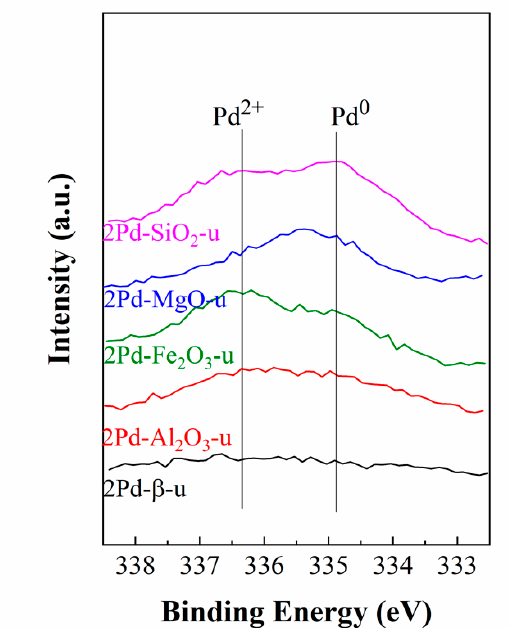
Figure 13. Pd 3d core level spectra for Pd-based catalysts, after FUR oxidative condensation reaction. Experimental conditions: temperature: 170 °C, time: 3 h, catalyst loading: 0.05 g, V (ethanol) :6 mL, amount of base (Na 2 CO 3 ): 0.10 g, V (H 2 O 2 , 30 wt%): 0.5 mL.